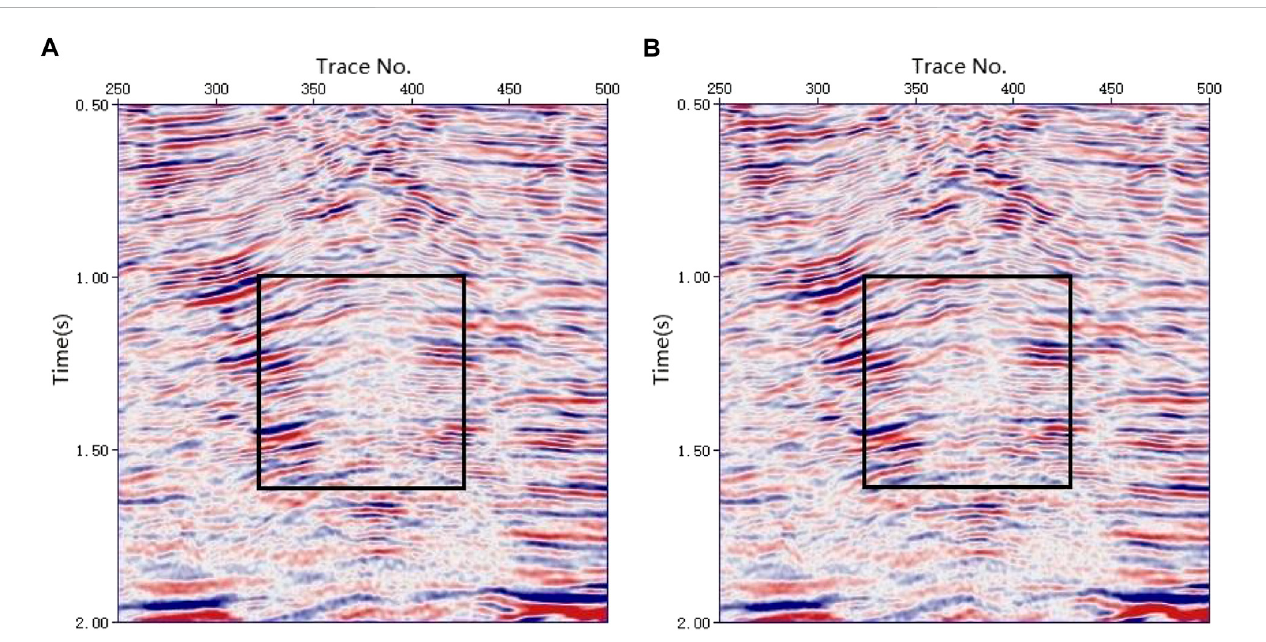
FIGURE 12 Enlarged display of the anticline. (A) Stacked pro fi le obtained by applying the manually picked velocities. (B) Stacked pro fi le obtained by applying the velocities picked by the weighted k-means clustering